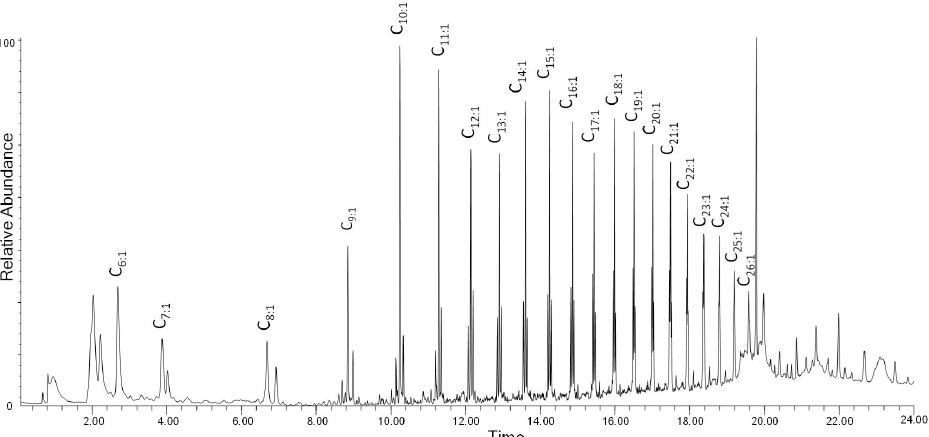
Figure 7. Chromatogram obtained in the Py–GC–MS analysis of the unaged low-density polyethylene (LDPE-0w). C n:1 refers to 1-alkenes of a given C n hydrocarbon. Peak identification is reported in Table S4 in Supplementary